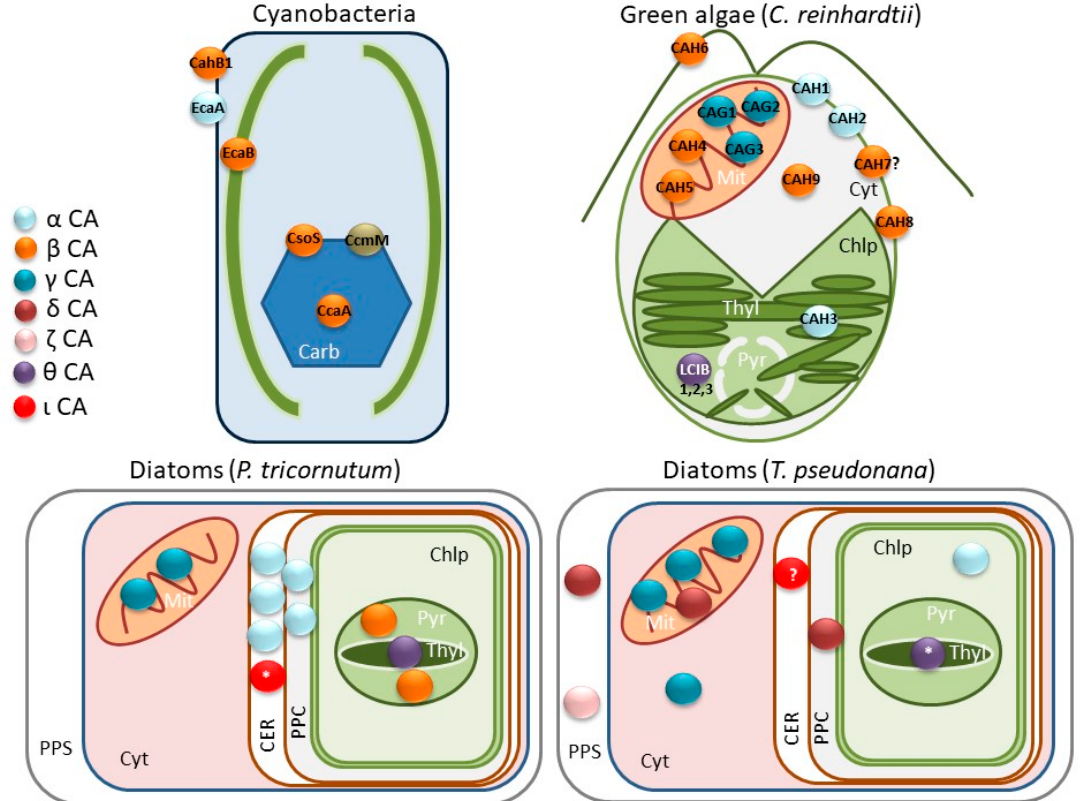
Figure 1. Distribution of the predicted carbonic anhydrases (CA) classes in some microalgae. Different CA classes are shown in colors as specified in the legend. In cyanobacteria and green algae, CAs appear also with their common names found in the literature. CAs whose subcellular localization is not fully demonstrated are shown with question marks (?); similarly, those that are predicted only by sequence homology appear with an asterisk (*). Carb: Carboxysome, Cyt: Cytoplasm, Mit: Mitochondrion, Chlp: Chloroplast (stroma), Thyl: Thylakoids (lumen), Pyr: Pyrenoid, PPS: Periplasmic space, CER: Chloroplast endoplasmic reticulum, PPC: Periplastidial compartment.